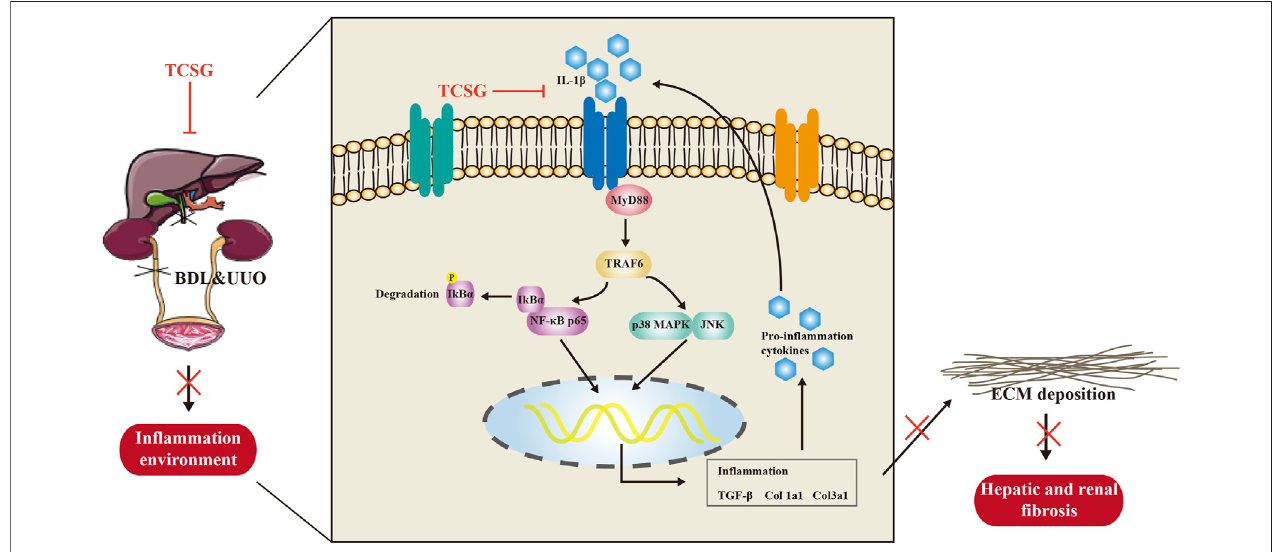
FIGURE 8 | The schematic diagram of the potential mechanism of TCSG from Baishouwu against hepatic and renal fi brosis.